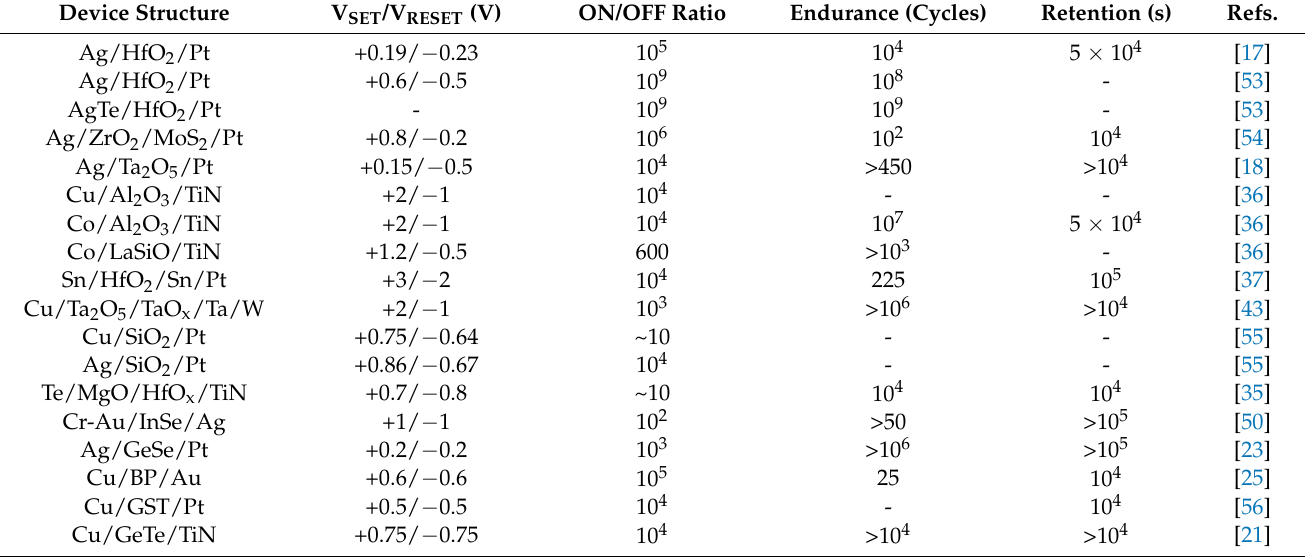
Table 1. Summary of key memory characteristics reported in several CBRAM devices based on different electrode and switching